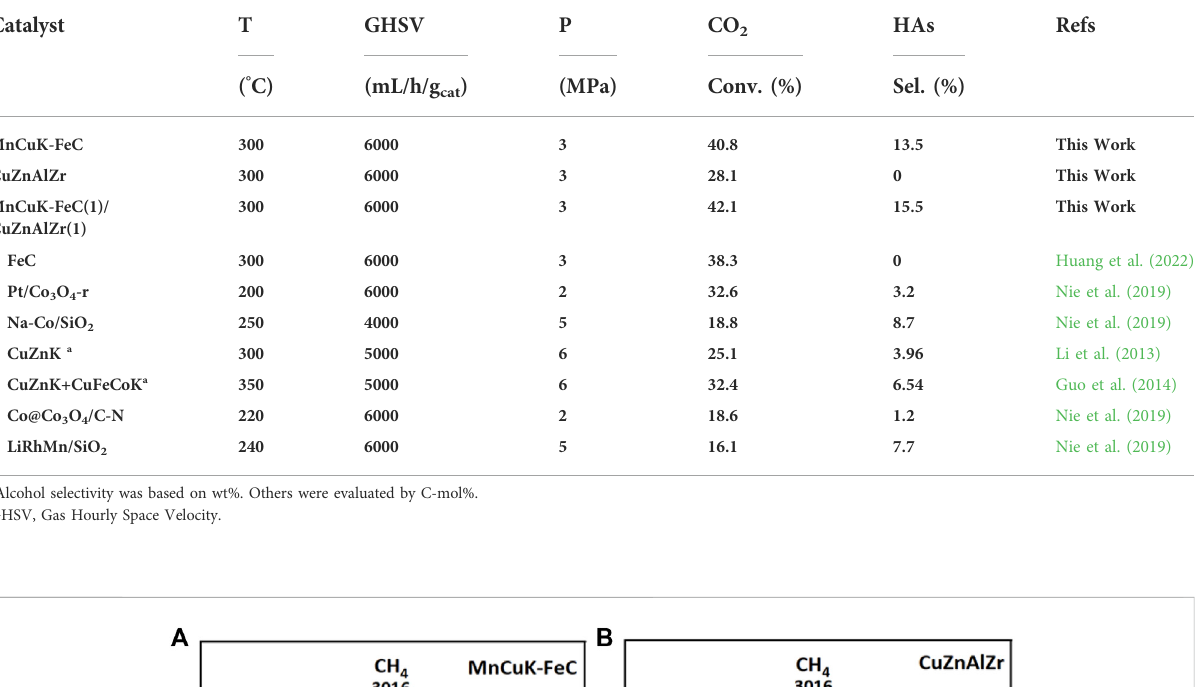
TABLE 3 Performance of CO 2 hydrogenation to higher alcohols.